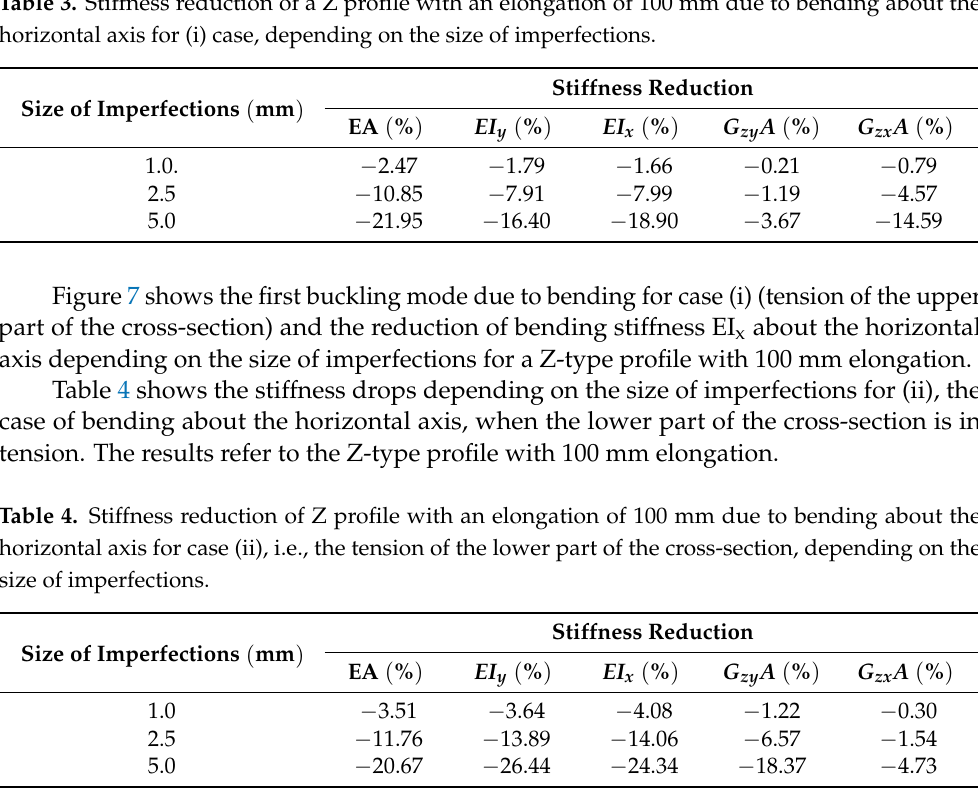
Figure 6. Buckling in compression for 200 mm depth: ( a ) mode 1; ( b ) mode 2; ( c ) plot of the stiffness reduction of EA, depending on the size of imperfections.